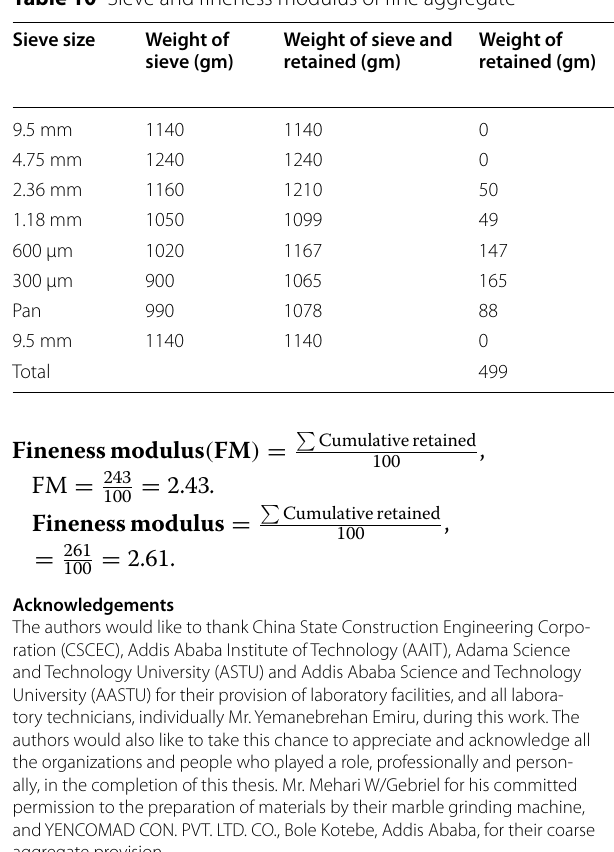
Table 10 Sieve and fineness modulus of fine